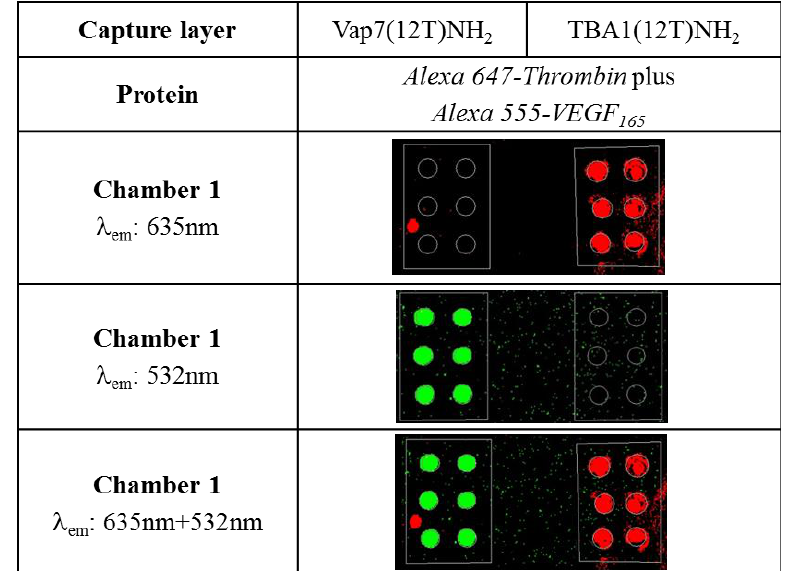
Figure 3. Images of the microarray slide after the simultaneous incubation of Alexa555-VEGF and Alexa647-thrombin (each 500 nM). On the same cell, Vap7(12T)NH 165 2 was anchored as capture layer for VEGF (left) and TBA1(12T)NH was anchored as 165 2 capture layer for thrombin (right). Green fluorescence (  : 532 nm) represents labeled em VEGF (Alexa 555) and red fluorescence (  : 635 nm) represents labeled thrombin 165 em (Alexa